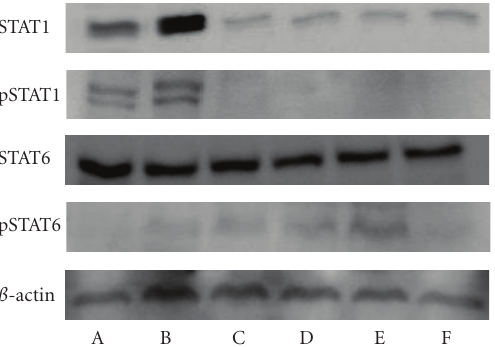
Figure 5: Concentration-dependent e ff ects of IO on LPS-induced STAT1, pSTAT1, STAT6, and pSTAT6 proteins expression in RAW 264.7 cells. (A) 0 LPS, (B) 1 μ g LPS, (C) 0.5mg LPS, (D) 1 mg LPS, (E) 2.5 mg LPS, and (F) 5 mg